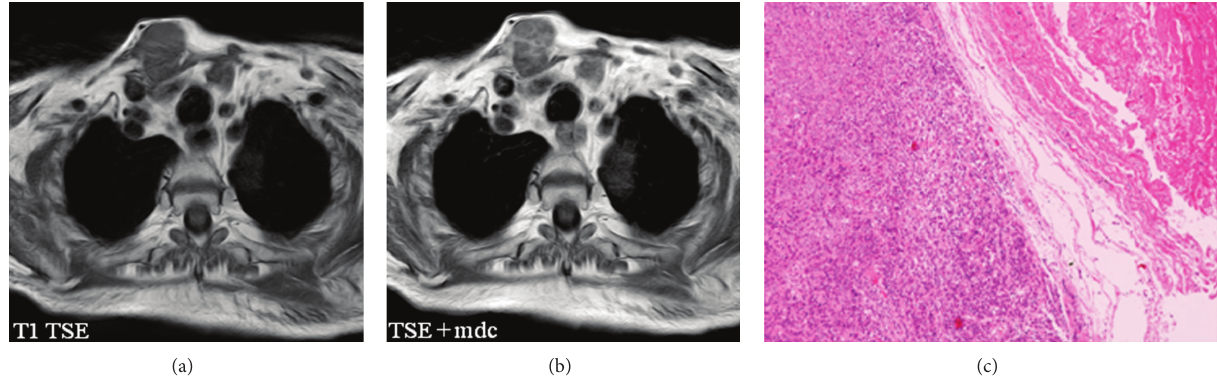
Figure 2: (a) and (b) MRI pre- (a) and postcontrast (b) scans showing a metastatic lesion in the right sternocleidomastoid muscle. (c) Hematoxylin and eosin staining of the sternocleidomastoid muscle lesion biopsy showing a metastasis from a poorly differentiated carcinoma (magnification: